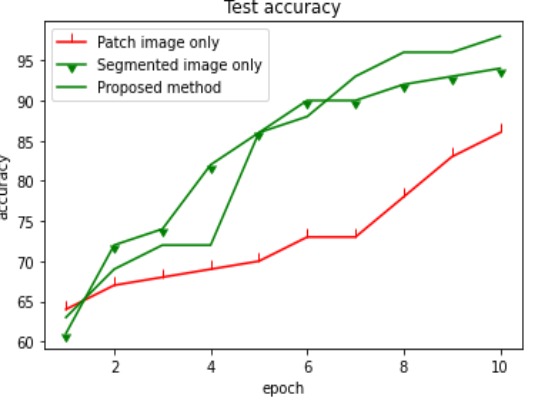
Figure 11. Accuracy on patch image only, segmented only, and the proposed approach (Guided approach).